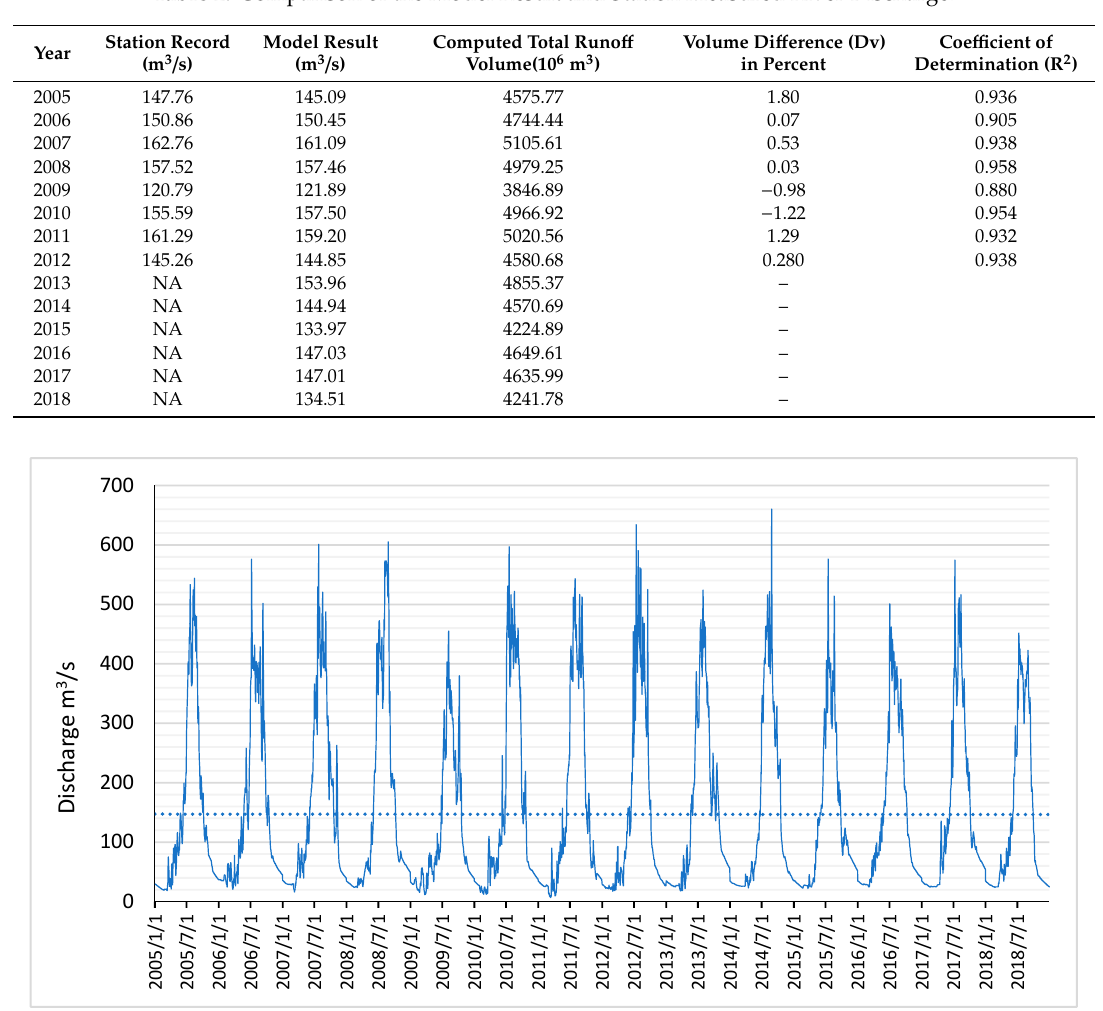
Figure 8. Daily calculated river discharge from 2005 to 2018.